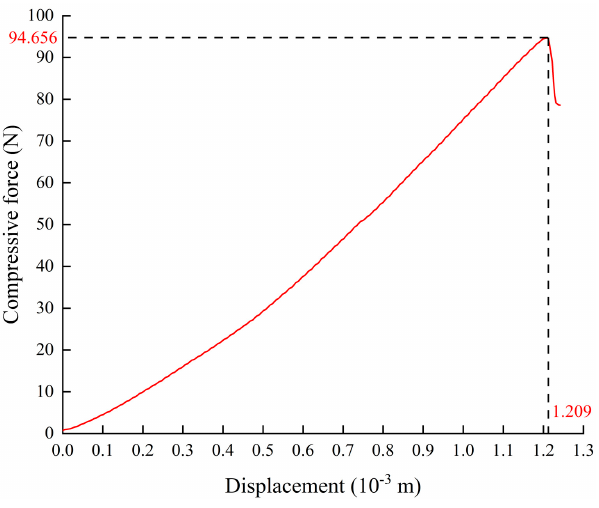
Figure 2. Force–displacement curve.